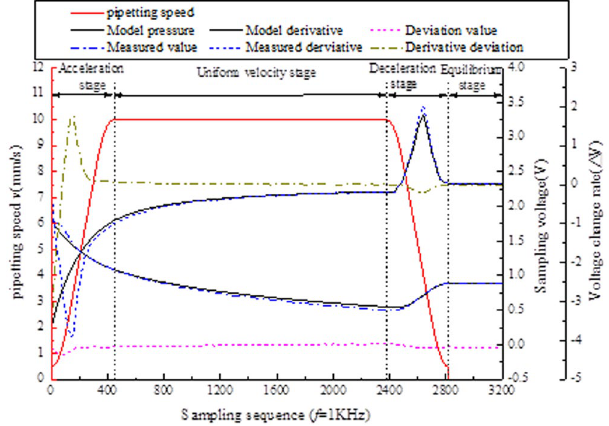
Figure 3. Comparison of the theoretical model with the actual sampling